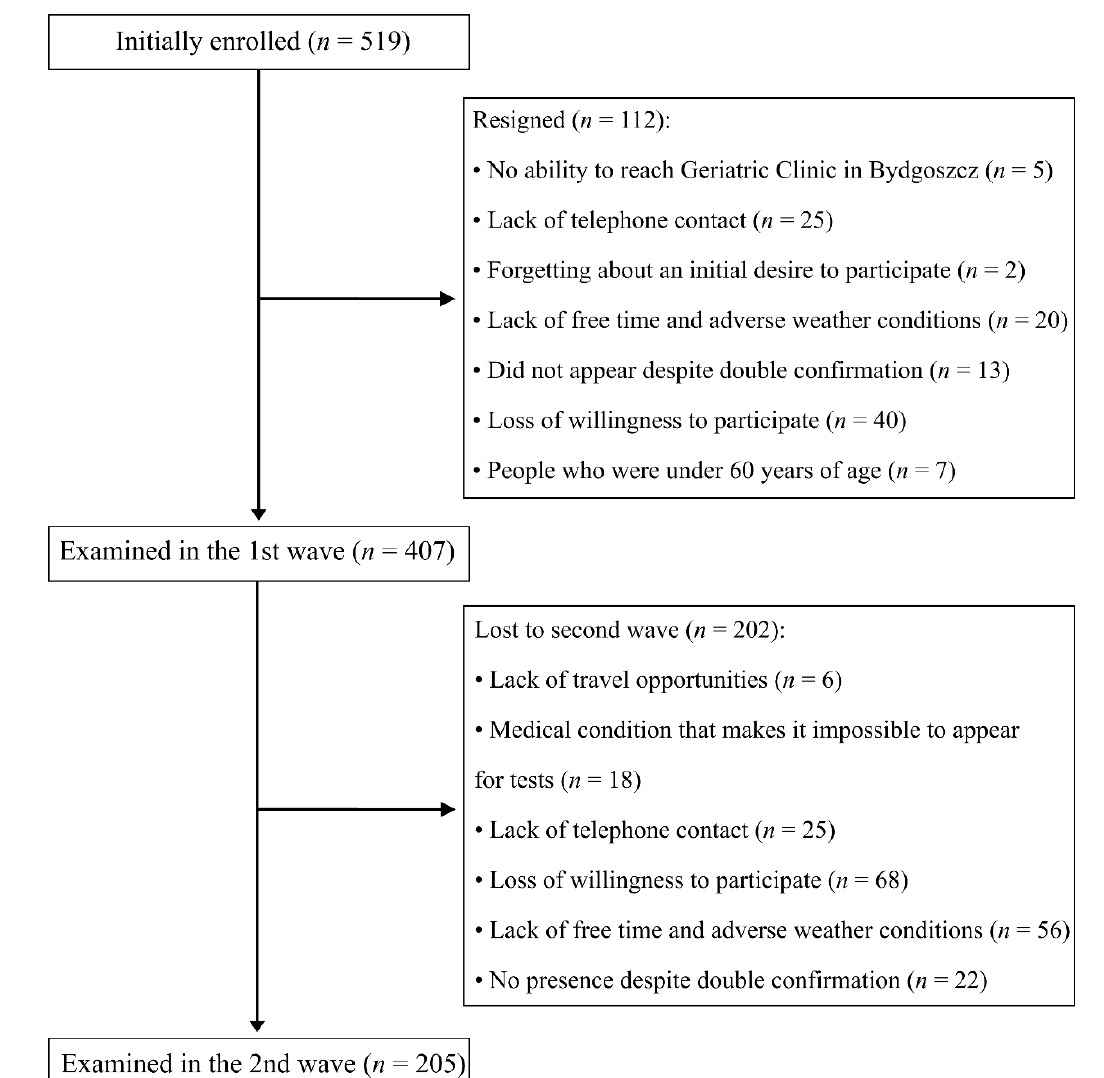
Figure 1. Flow chart of the study.